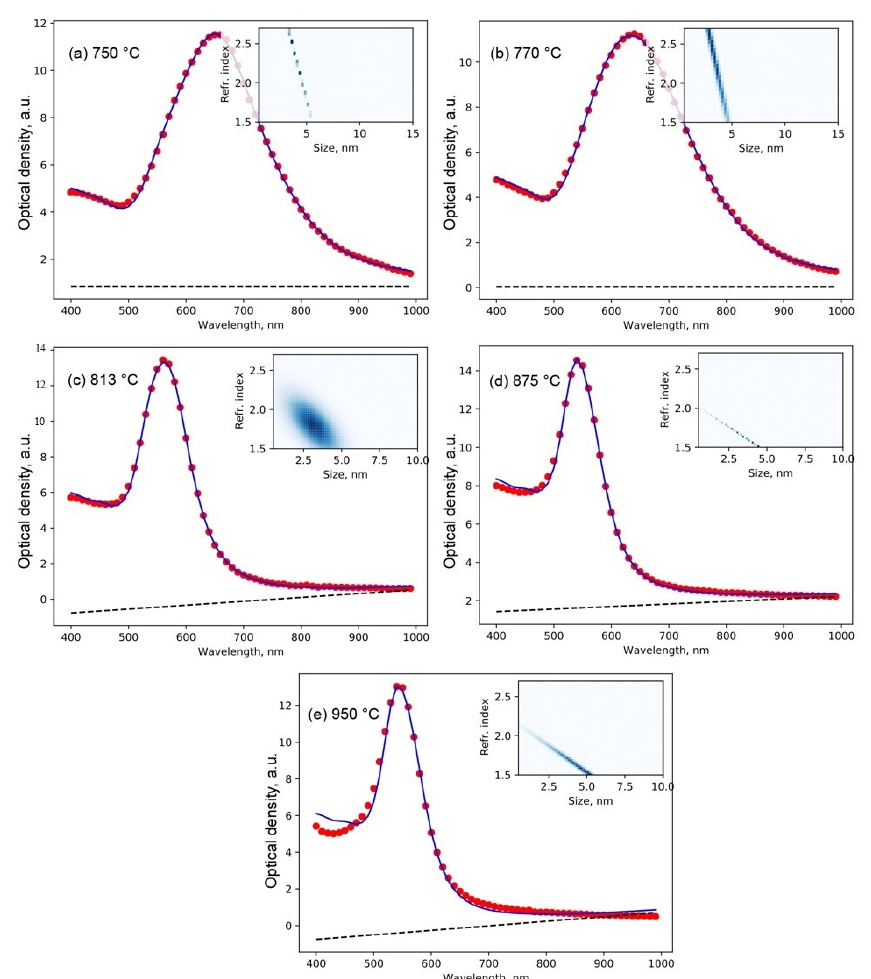
Figure 12. ( a – e ) Fitting quality of the absorption spectra of the Au-doped glass samples upon the heat treatment in the 750–950 ◦ C range. Red dots—experimental spectrum, solid blue line—theoretical spectrum, dashed line—background contribution. The inset illustrates the obtained 2D normal distribution of NPs over the sizes and glass refraction index defined by Equation